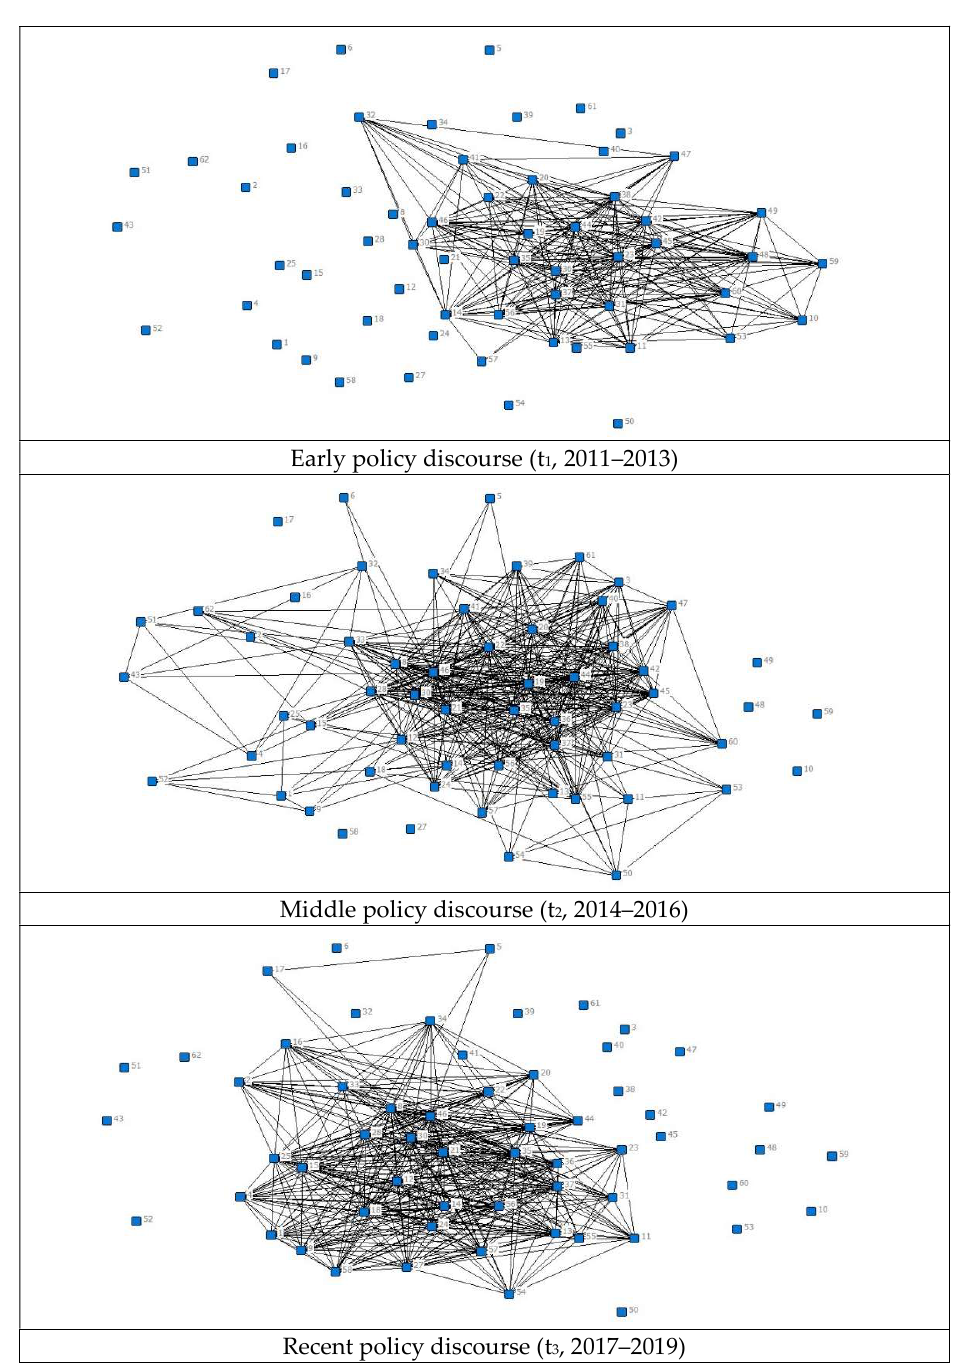
Figure 5. Policy communication networks among Ki-no-Eki organizations over time. ( Notes : Undi- rected ties between Ki-no-Eki organizations indicate that both attended the same policy forum during a specific time period. The network sociograms of the Ki-no-Eki organizations were drawn by UCINET 6 [40]). Table 1. Structural characteristics of policy communication networks among Ki-no-Eki organizations over time.